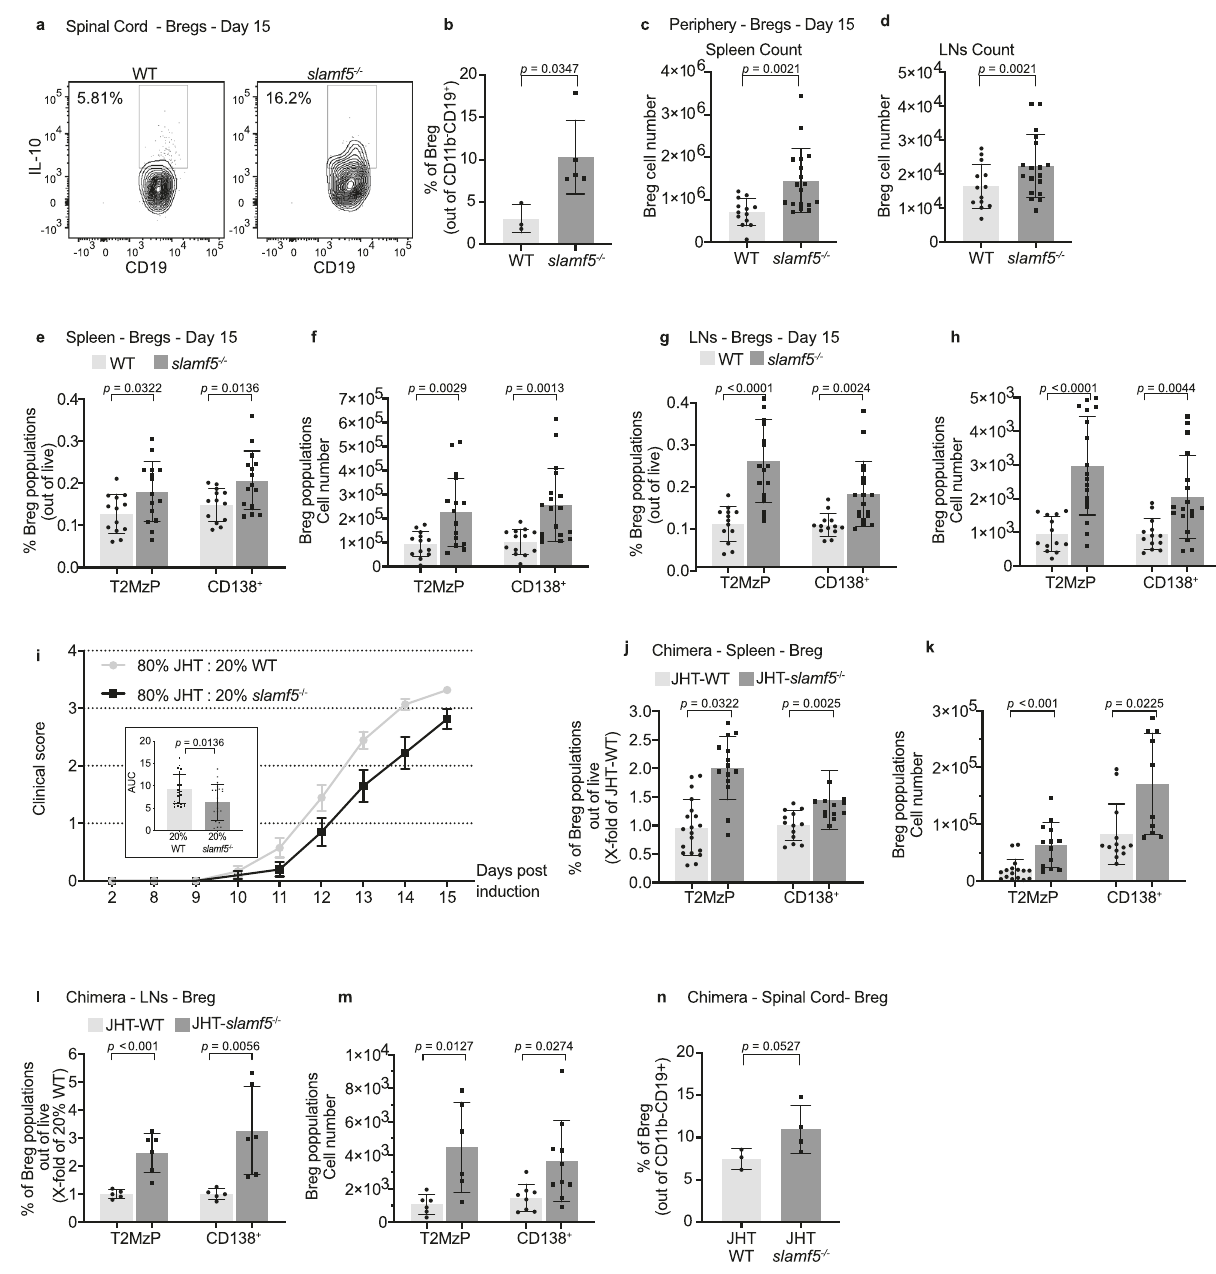
Fig. 2 SLAMF5 de fi ciency regulates Breg levels. EAE (MOG 35-55 ) was induced in WT and slamf5 − / − mice. a , b On day 15, the spinal cords were analyzed the for Breg population according to the following markers: CD45 + CD11b − CD19 + CDIL-10 + ; a representative dot plot, and b bar graph showing the mean population percentages. Each dot represents a pool of four to fi ve mice with similar disease scores, (WT n = 3; slamf5 − / − n = 5, two independent experiments). c – h On day 15, spleens and lymph nodes (LNs) were analyzed. Total Breg (CD19 + IL-10 + ) cell numbers in ( c ) the spleen and ( d ) LNs (WT n = 13; slamf5 − / − n = 18, two independent experiments), subpopulations of T2-MzP Breg (CD19 + IL-10 + CD24 + CD21 + CD23 + ) and CD138 + Bregs (CD19 + IL-10 + CD138 + ) were analyzed for percentages and cell number in ( e , f ) the spleen (WT n = 13; slamf5 − / − n = 15, two independent experiments) and ( g , h ) LNs (WT n = 13; slamf5 − / − n = 18, two independent experiments) ( i – n) CD45.1 WT mice were lethally irradiated and injected with BM consisting of 80% JHT BM and 20% WT-CD45.2 or slamf5 − / − BM. Following BM reconstitution, EAE was induced, and mice were followed for 15 days. i Mean clinical scoring of the disease. Inset depicts the area under the curve for days 0 – 15 (20% WT n = 24; 20% slamf5 − / − n = 20, three independent experiments). On day 15, Breg populations were analyzed in the spleen by FACS for ( j ) percentages (20% WT T2MzP n = 19; CD138 + n = 13; 20% slamf5 − / − T2MzP n = 14; CD138 + n = 13, three independent experiments) and ( k ) cell number (20% WT T2MzP n = 16; CD138 + n = 13; 20% slamf5 − / − T2MzP n = 13; CD138 + n = 10, three independent experiments) . LN Bregs were analyzed for their ( l ) percentage (each dot represents four to fi ve mice with a similar score, 20% WT n = 6; 20% slamf5 − / − n = 5, three independent experiments), and ( m ) cell count (20% WT T2MzP n = 6; CD138 + n = 8; 20% slamf5 − / − T2MzP n = 6; CD138 + n = 10, three independent experiments). n Spinal cord Bregs (each dot represents four to fi ve mice with a similar score, 20% WT n = 3; 20% slamf5 − / − n = 4, two independent experiments) were analyzed. Data expressed as mean±s.d. ( b – h , i inset, n ) and mean±s.e.m. ( i ). Unpaired Student ’ s t test with 95% con fi dence levels two-tailed ( b – h , j – m ) or one- tailed ( n ), Mann – Whitney test ( i insets). Gating strategy for a , b , n is shown in Supplementary Fig. 2a, gating strategy for a – d , e – h , j , k is shown in Supplementary Fig. 2b.